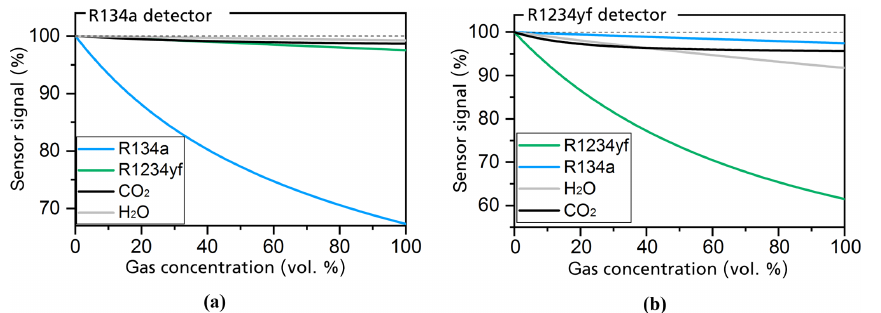
Figure 5. Simulations of the detector’s response to the R134a (a) and R1234yf (b) refrigerants as well as the ambient gases H 2 O and CO 2 at a respective gas concentration range of between 0 and 100vol.% (Weber et al., 2019). All set geometries and conditions are the same as those of the simulations in Fig. 4.